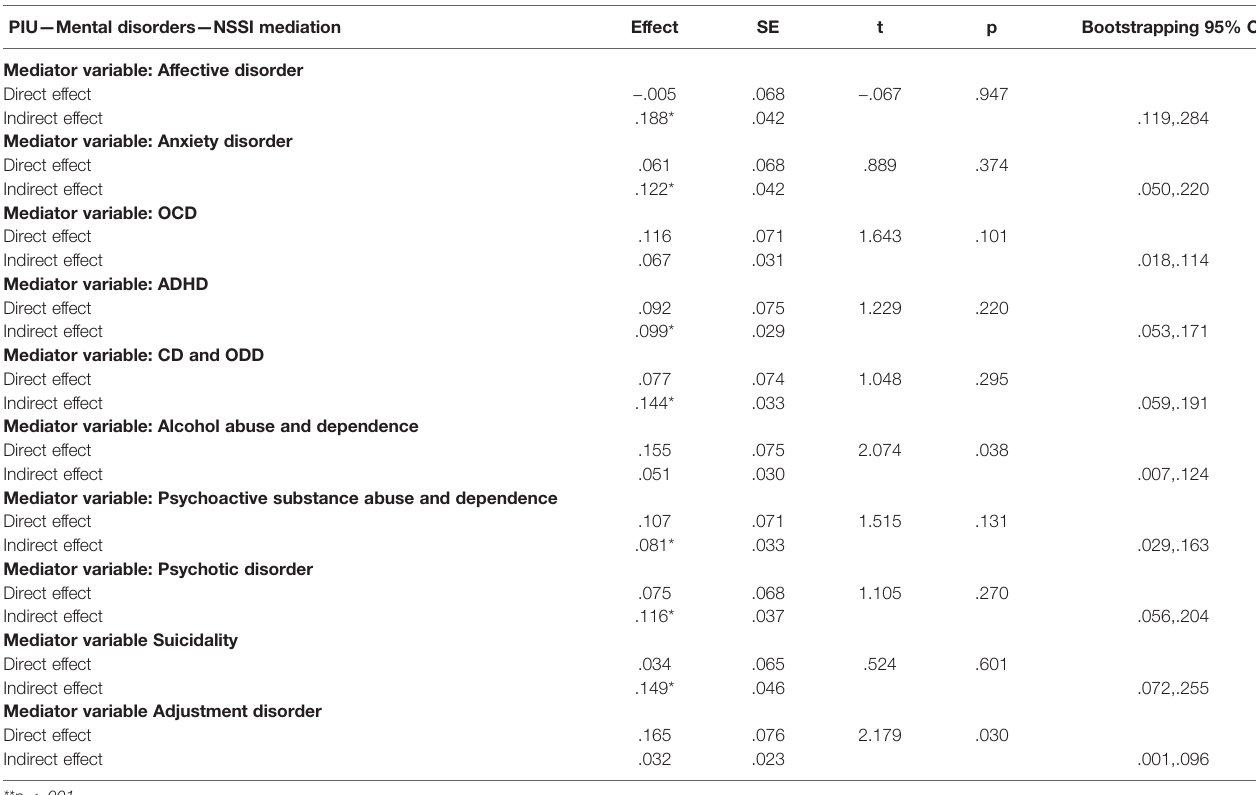
TABLE 7 | Direct and indirect effects of internet use on NSSI through mental